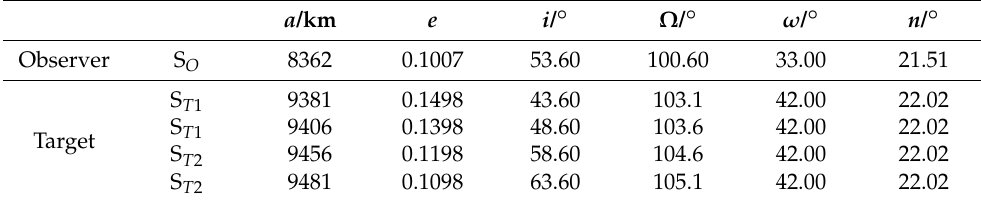
Table 1. Nominal orbit elements of the target and the observer.